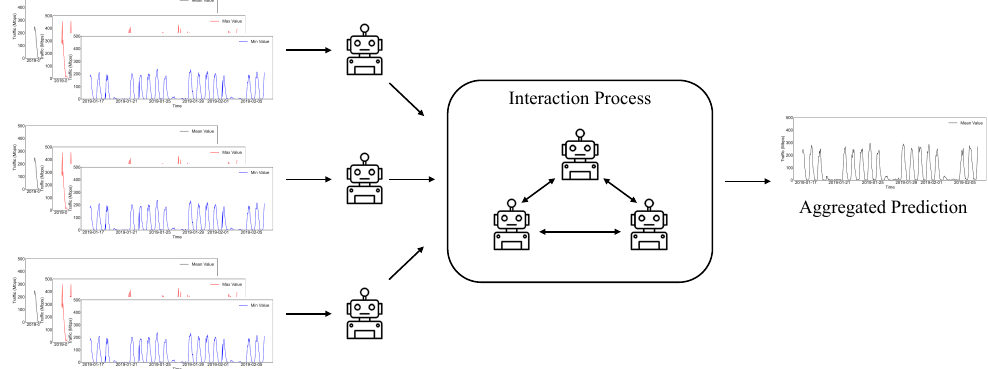
Figure 2. The general process of the proposed distributed multi-agent learning